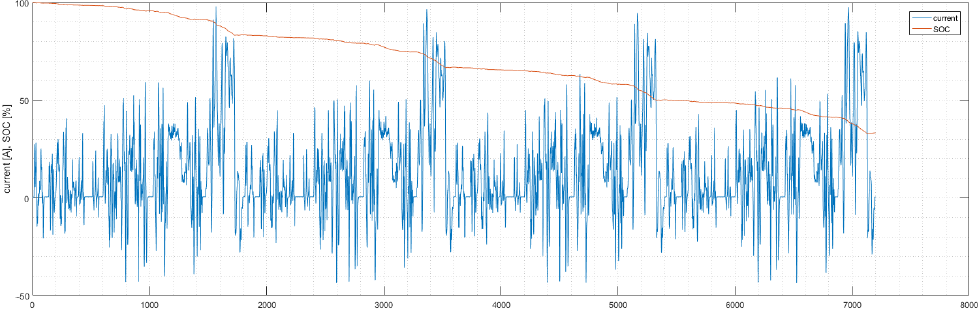
Figure 3. Battery current waveform calculated for single cell used in the model of BEV. The final drive cycle discharge cycle for the experiment consists of the presented electric current followed by CC/CV